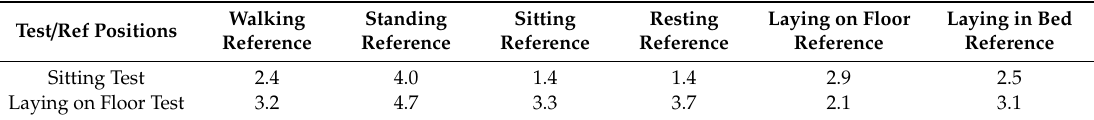
Table 3. Euclidean distance for “Sitting on the chair” and “Laying on the floor” of patients with the reference position database.